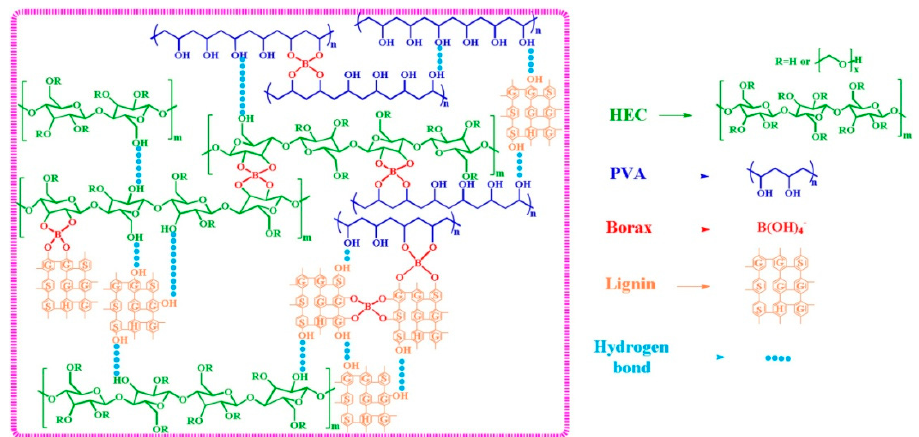
Figure 3. Schematic representation of the structure mechanism of PVA/HEC/lignin hydrogels with valuable self-healing properties Reproduced with permission from Huang et al. [37] Copyright © (2019) Elsevier..